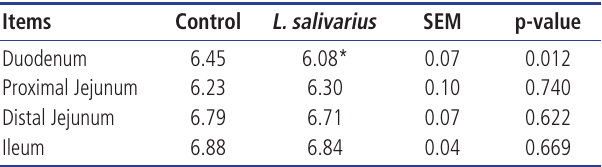
Table 4. Effect of Lactobacillus salivarius on pH of intestinal contents of piglets challenged with Escherichia coli F4 Items